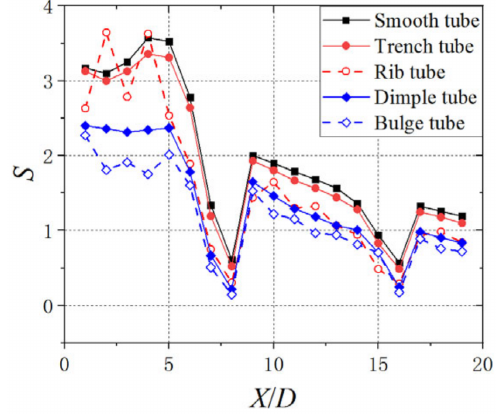
Figure 11. Local swirl number on different cross sections in the swirl tube with various surface structures at Re D = 50,000 with three